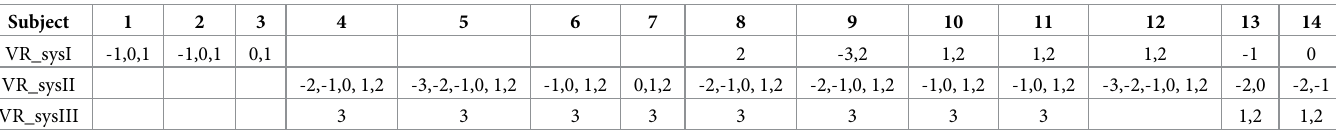
Table 3. MSAQ data available for each participant.